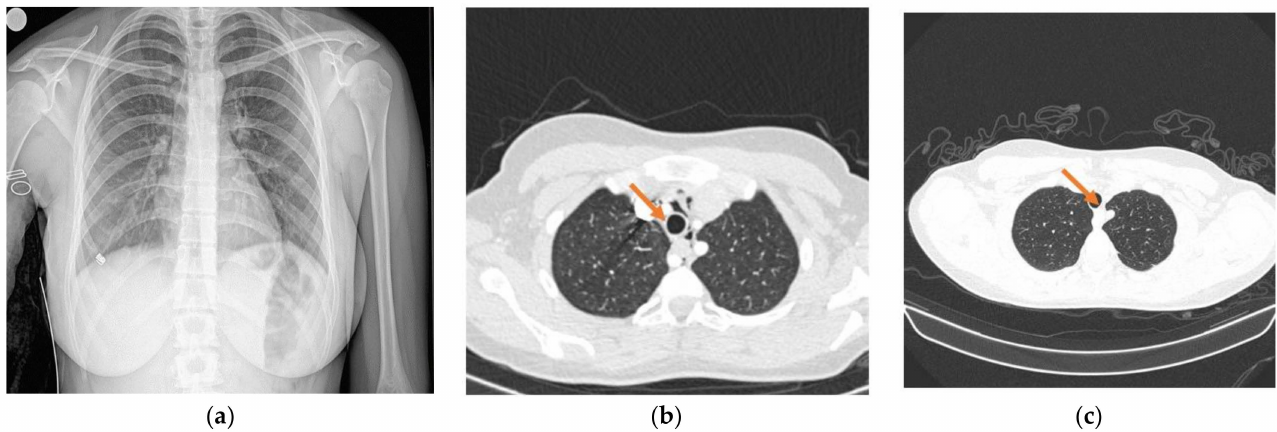
Figure 1. X-ray and CT images. ( a ) Chest radiograph—no abnormalities (Day 0); ( b ) chest